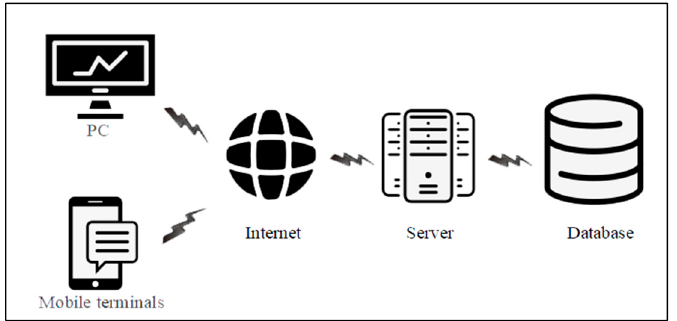
Figure 13. The physical structure of the system.